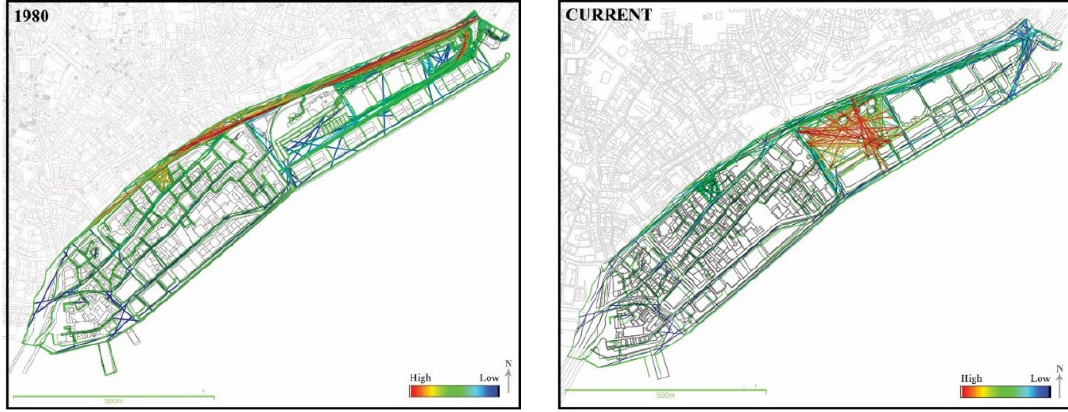
Figure 16 Detailed representation of local integration map (Rn 800) of the area in 1980 (left) and 2020